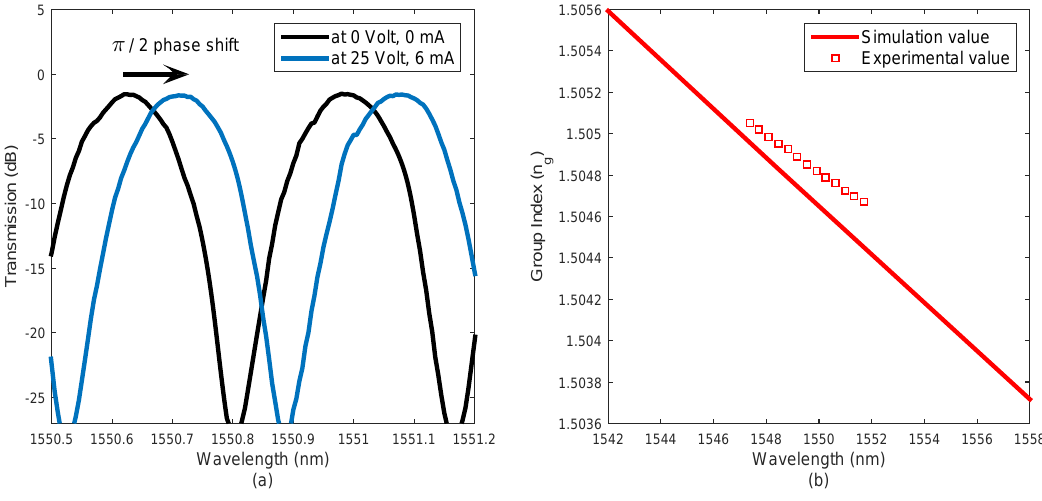
Figure 9. ( a ) Optical transmission response of the test MZI filter at two different bias voltages to the heater, ( b ) Measured and calculated group index of the 72 nm thick Si 3 N 4